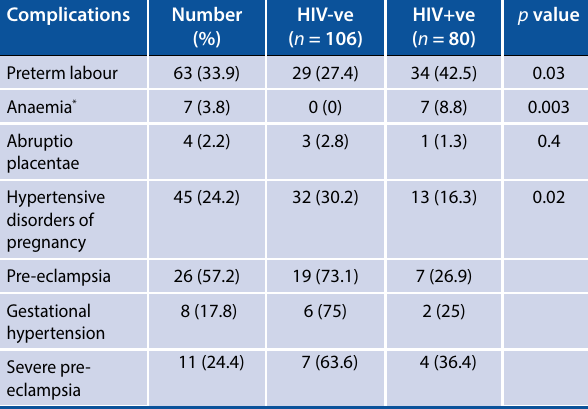
* 3 cases of severe anaemia in the HIV infected group was ART (zidovudine) related. Anaemia (<10 g/dL) was present in 42.5% ( n = 34) of